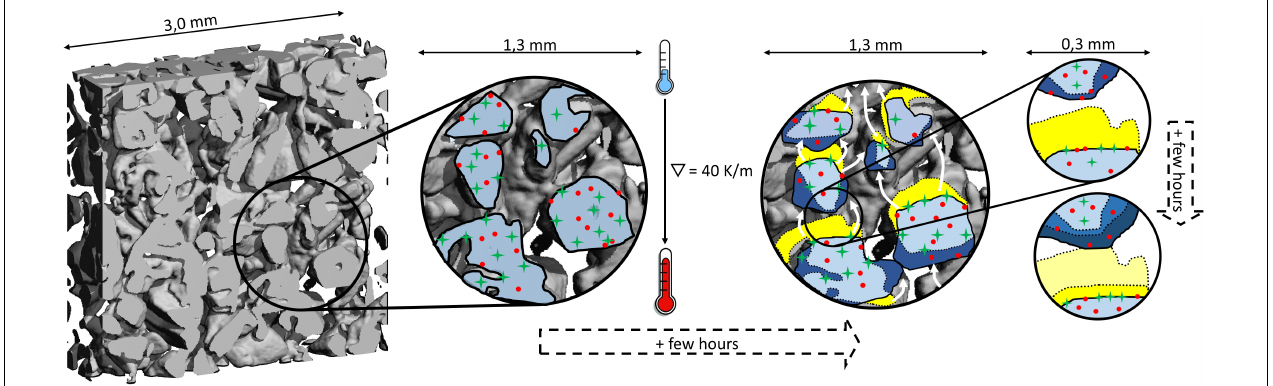
FIGURE 8 | Visualization of redistribution of impurities (red dots, green crosses) during temperature gradient metamorphism. The reconstruction of the ice matrix is driven by the vapor transport between neighboring ice interfaces (white arrows). Ice mass sublimates (yellow area) and deposits at the nearest cold interface leading to the growth of ice there (dark blue area). Impurities – very general either in the form of ions, deposits, or liquid fraction – from the sublimating ice remain at the newly formed ice interface. The specific tendency of impurities to be incorporated into the growing ice (red dots show higher tendency than green crosses) ultimately drives the observed changes in accessibility during temperature gradient